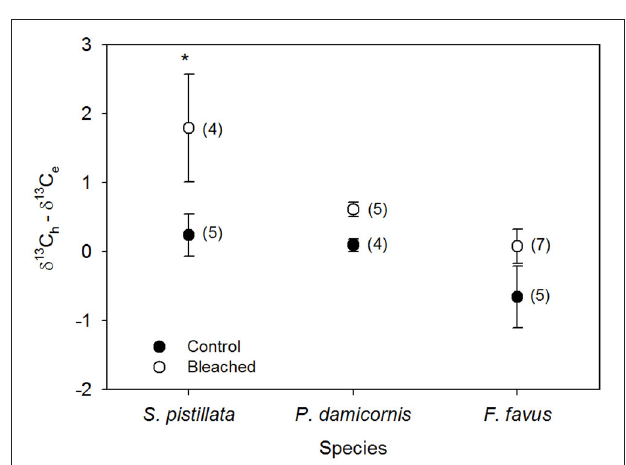
FIGURE 4 | Average difference between host ( δ 13 C h ) and endosymbiont ( δ 13 C e ) stable carbon isotope values in bleached (open circles) and control (black circles) Stylophora pistillata , Pocillopora damicornis , and Favia favus corals from Figures 3C,D . Heterotrophy contributes more to the fixed carbon pool when the difference is < 0, while photosynthesis contributes more when the difference is ≥ 0. Averages are plotted ± 1 standard error calculated through error propagation and are reported in permil ( h ) relative to V-PDB. Sample sizes for each average are in brackets. Significant differences between control and bleached within each species are indicated with *. Corresponding ANOVA results are given in Table 3 .